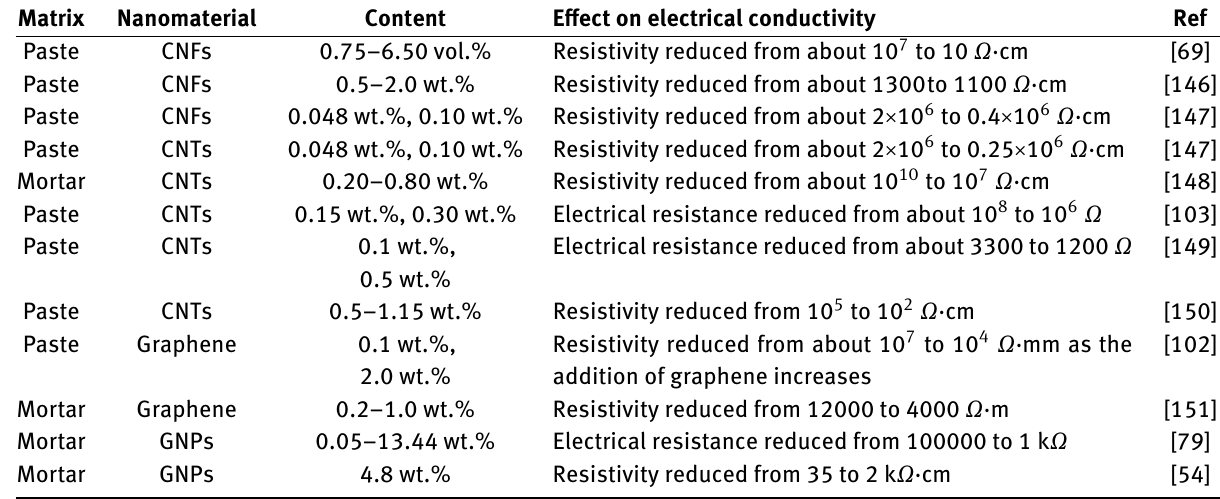
Table 4: Effect of carbon nanomaterials on the electrical conductivity of cement-based materials